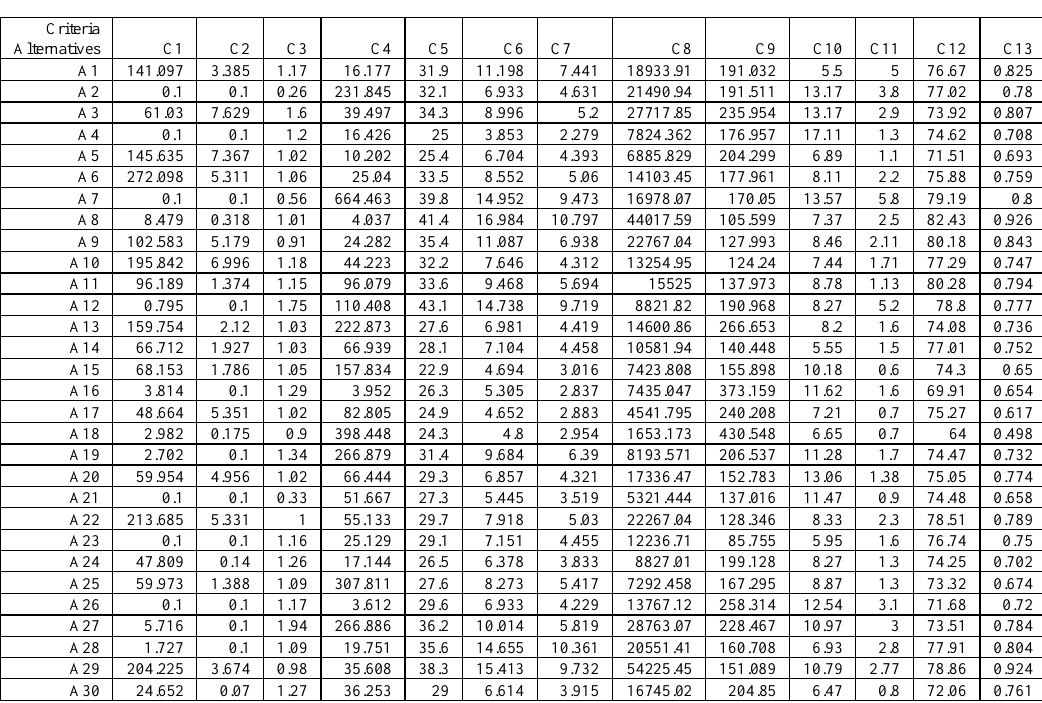
Table 1. Decision Matrix of information as on 30 th July 2020.